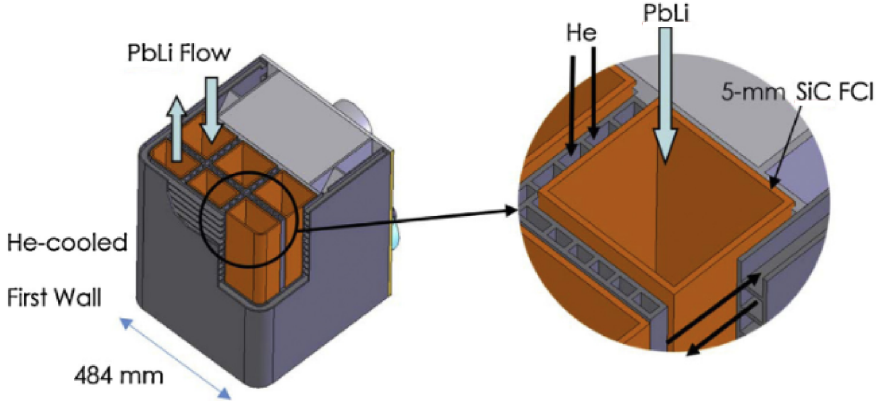
Figure 3. Schematics of the DCLL blanket with poloidal channels and SiC flow channels inserts [30]. There are two approaches to the DCLL blanket configuration as shown in Figure 4.